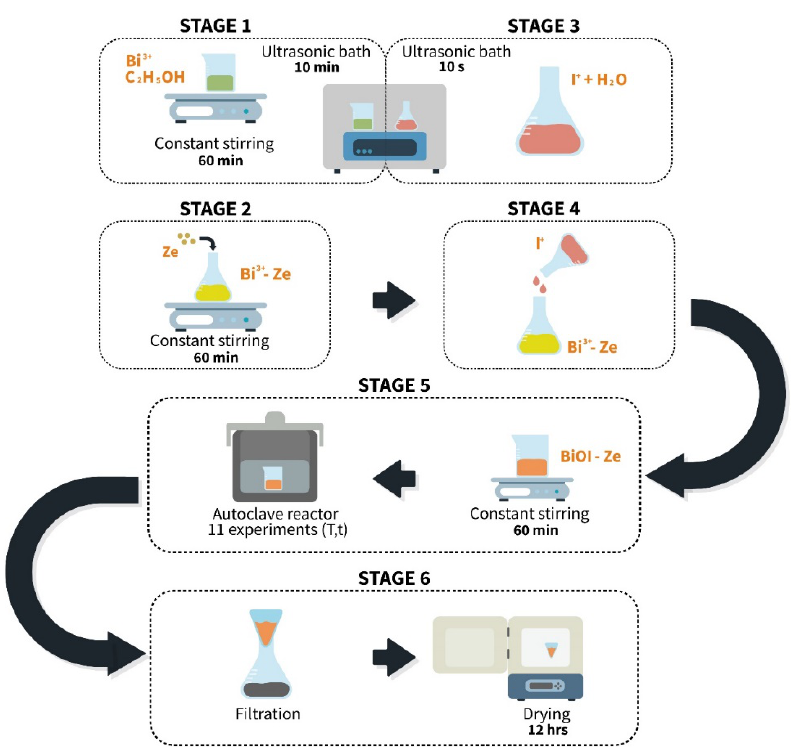
Figure 1. Graphical representation of the synthesis procedure to obtain BiOI/mordenite composites using a combined coprecipitation-solvothermal growth method.